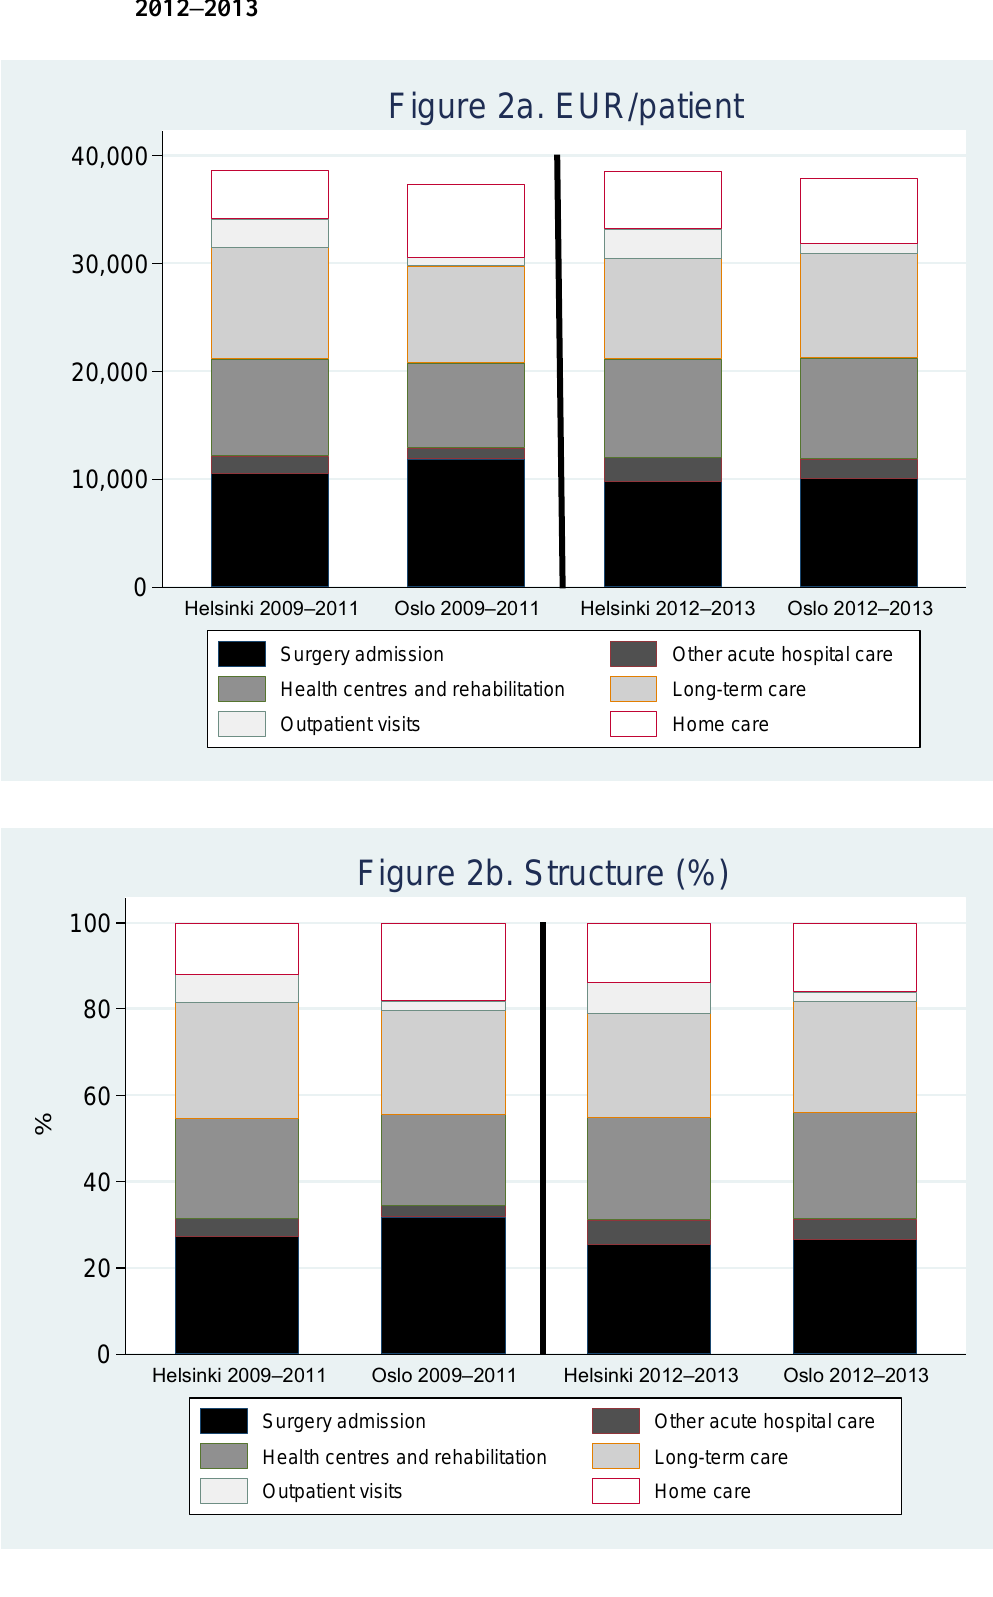
Figure 2: Age, sex, and type of fracture standardised one-year cost 2009–2011 and 2012–2013 Figure 2a. EUR/patient